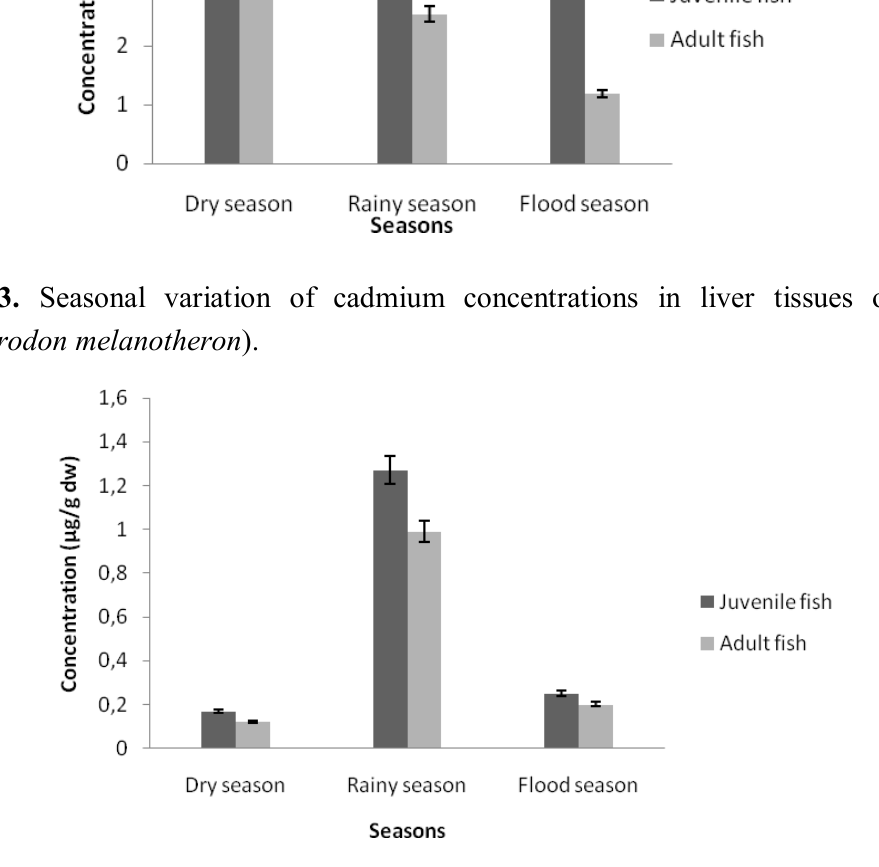
Figure 4. Seasonal variation of cadmium concentrations in gill tissues of tilapia ( Sarotherodon melanotheron